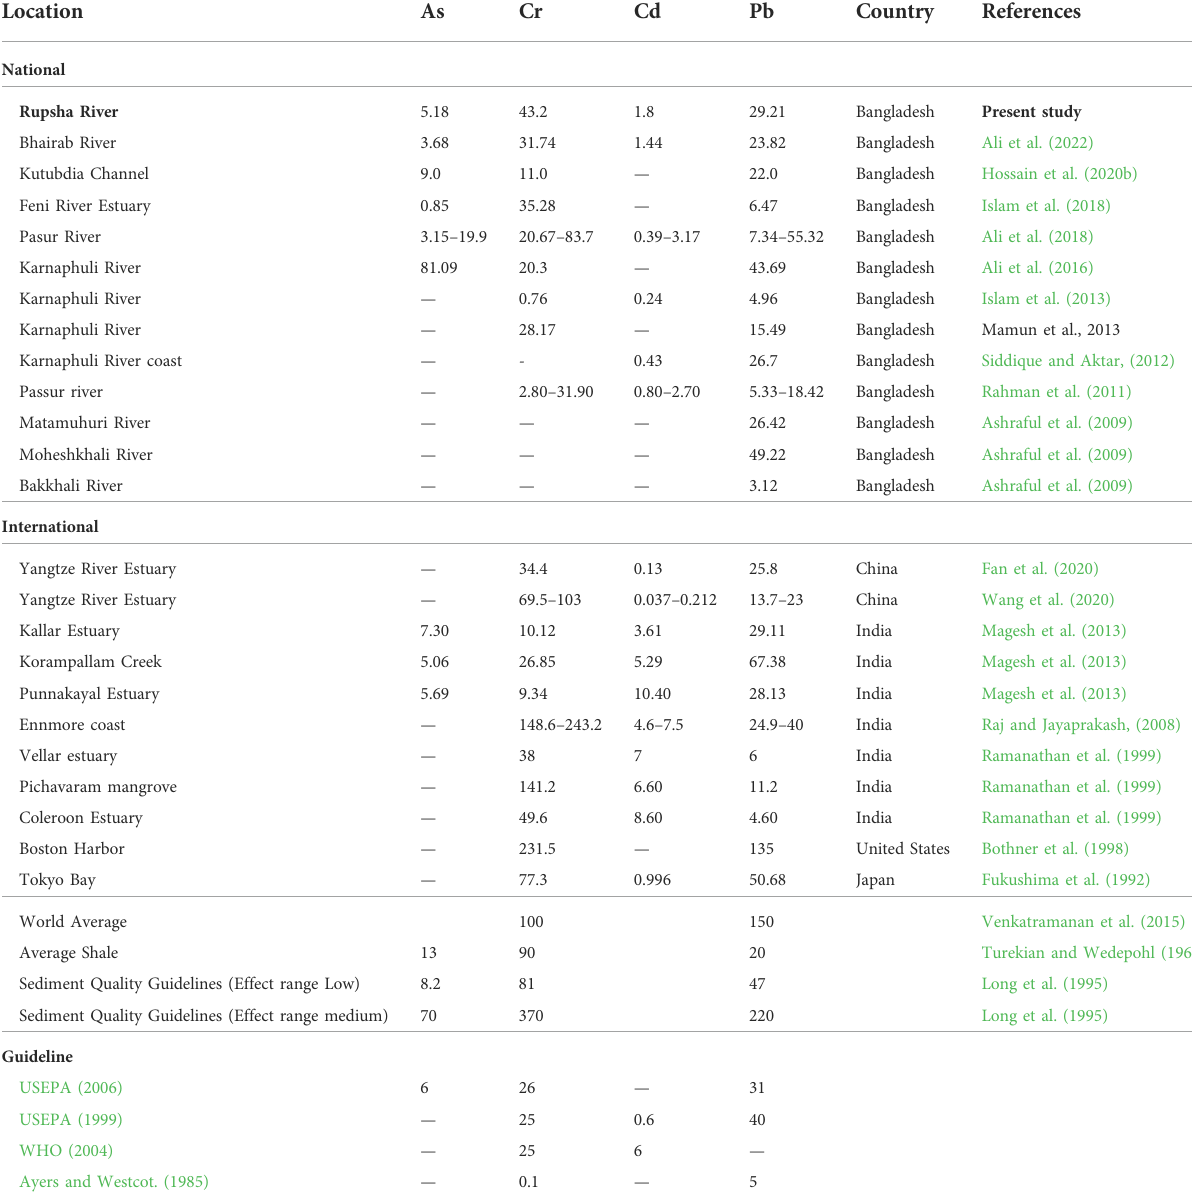
TABLE 2 Metal concentrations (mg/kg) in the estuary and coastal sediment from throughout the world are compared.